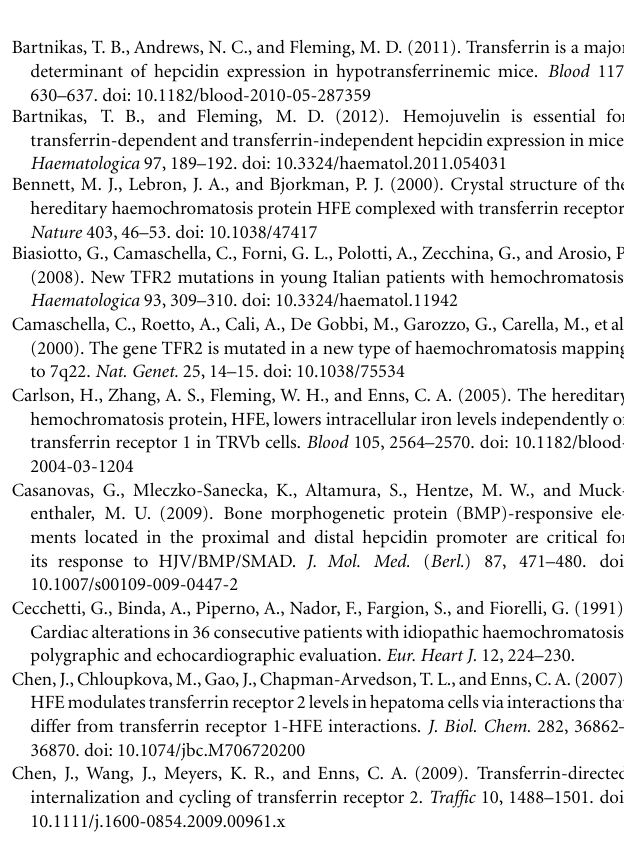
FIGURE 1 | Models ofTf/TfR2-induced upregulation of hepcidin transcription. (A) TfR2 and HFE act independently to increase pSMAD induction of hepcidin transcription. (B) Tf induces the formation of a large